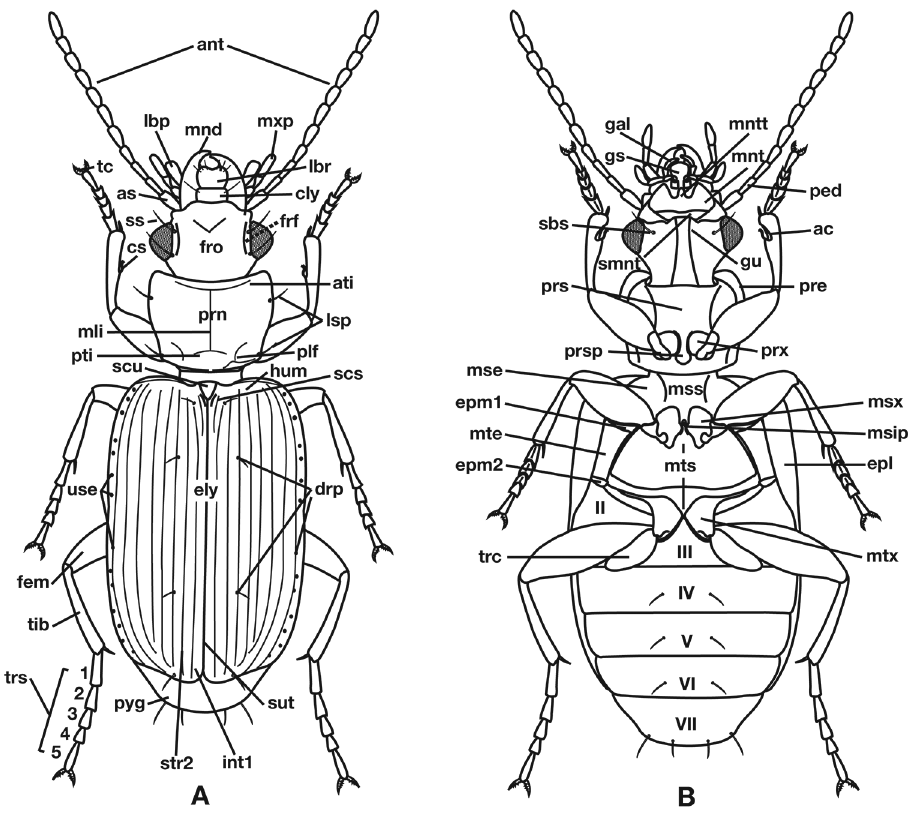
Figure 1. Structure of a generalized lebiine ground beetle (Carabidae) A dorsal view B ventral view. Adapted from Hunting,